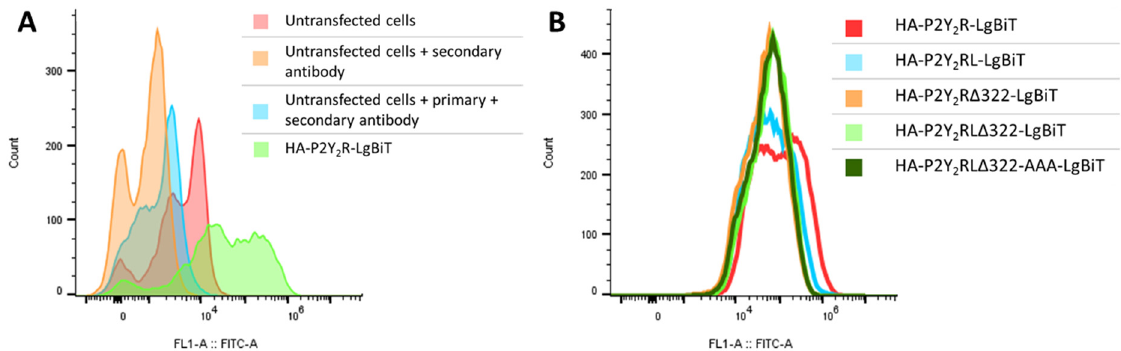
Figure 4. Outcome of the flow cytometry analysis to determine surface expression of the generated HA-tagged P2Y 2 R-constructs in the NanoBiT ® system. ( A ) Verification of the used protocol, com- parison of control situations (untransfected cells with/without antibodies) and one of the generated constructs (in green). ( B ) Comparison of the fluorescence intensity between the different generated constructs after gating the cells that are positive for the transfection control mTurquoise. One rep- resentative experiment of three independent replicates is shown.